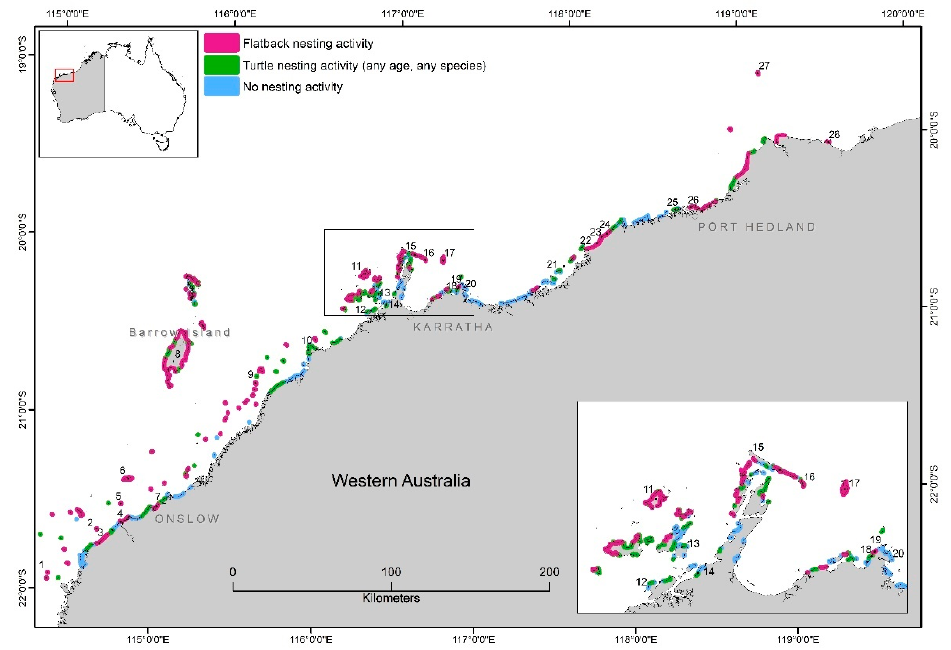
Figure 1. Beaches in the Pilbara region of Western Australia surveyed between 29th November and 6th December 2016 by digital aerial photography showing presence (green) and absence (blue) of marine turtle nesting activity. Turtle activity was defined as any track, nest or body pit of any age observed on a beach and/or in the sand dunes and made by any species of marine turtle. Fresh flatback nesting activity (0 – 36 h. old) is also shown (pink). (1) Y Island, (2) Locker Island, (3) Urala Beach, (4) Ashburton Delta, (5) Ashburton Island, (6) Thevenard Island, (7) Beadon Creek-Onslow, (8) Barrow Island, (9) Long Island, (10) Cape Preston, (11) Rosemary Island, (12) West Intercourse Island, (13) East Lewis Island, (14) Dampier town, (15) Legendre Island, (16) Hauy Island, (17) Delambre Island, (18) Cape Lambert, (19) Bells Beach, (20) Point Samson, (21) Forestier Islands, (22) Cape Cossigny-Mundabullangana, (23) Cowrie Beach west-Mundabullangana, (24) Cowrie Beach main-Mundabullangana, (25) Downes Island, (26) Cemetery Beach-Port Hedland, (27) Bedout Island, and (28) Mulla Mulla Downs Creek. Inset map (grey rectangle) highlights beaches 11 to